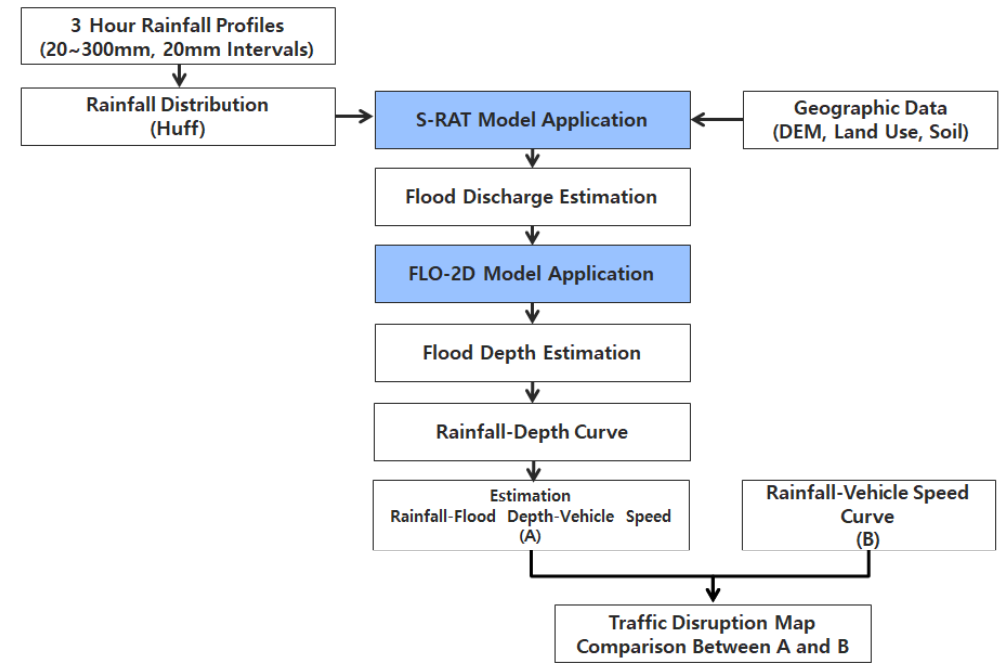
Figure 1. Flowchart of the study.